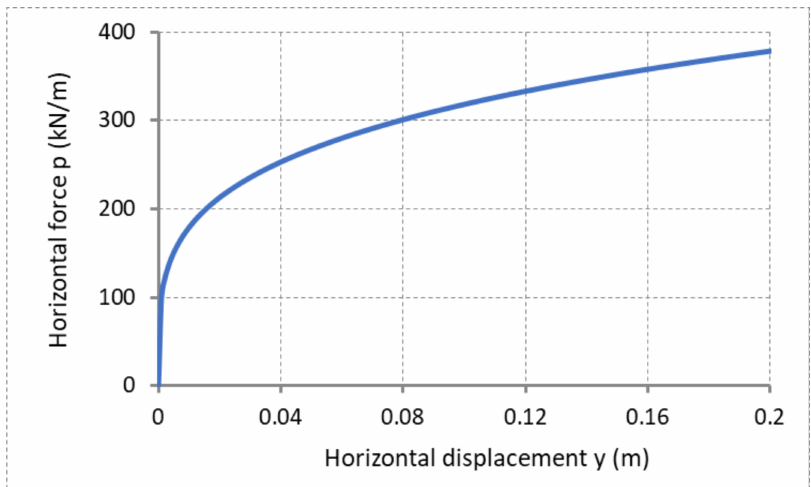
Figure 11. p–y curves representing soil–pile